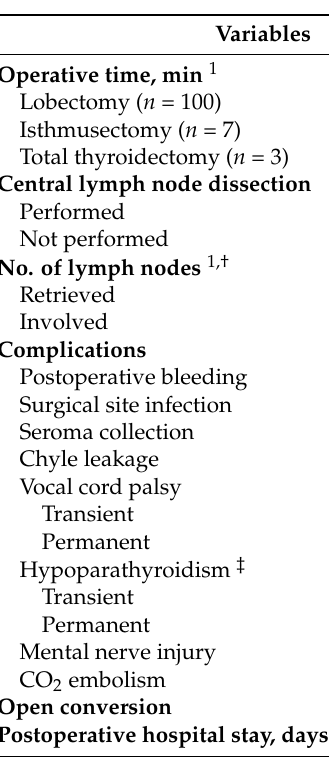
Table 2. Operative details and postoperative